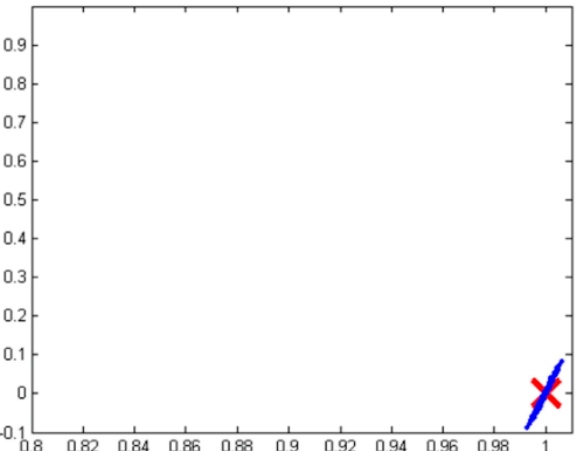
Figure 2. Illustration of deleterious effects of position and rate sensor noise on tracking performance of modern algorithms. Image taken from [4]. The desired state is indicated by a red ‘x’, and the result of simulations are the blue data points. Horizontal axis is angular position and vertical is angular velocity (rate), similar to the state being used in the problem de fi ned in Section 2.